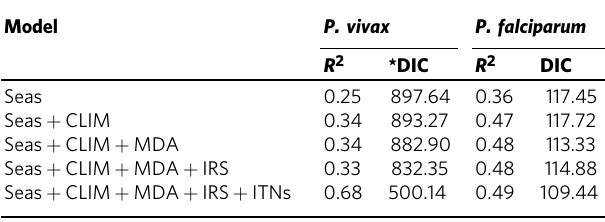
Seas seasonal component, CLIM climatic component, MDA mass antimalarial drug administration, IRS indoor residual spraying, ITNs insecticide-treated bed nets. * DIC deviance information